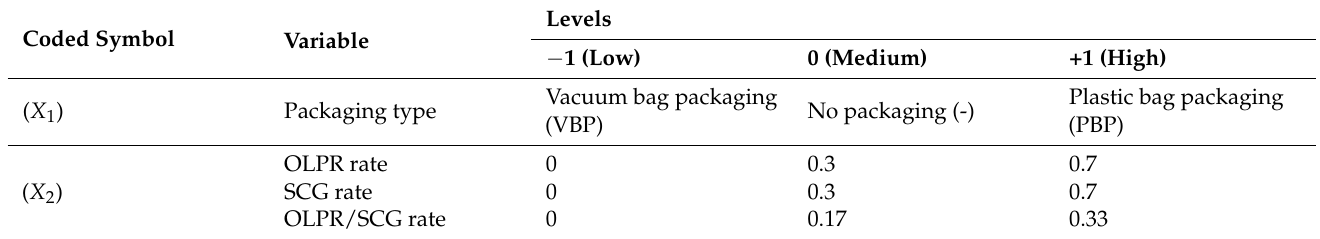
Table 1. Actual and coded levels of the experimental variables (factors) for mushroom shelf-life